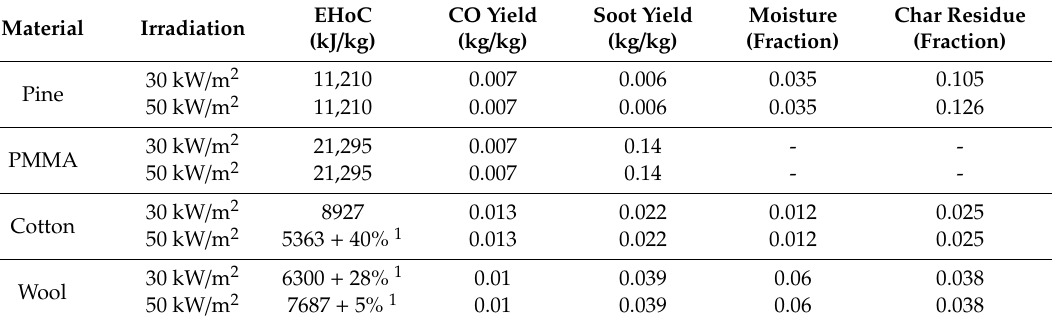
Table 3. Flammability Properties, Moisture and Char Residue.